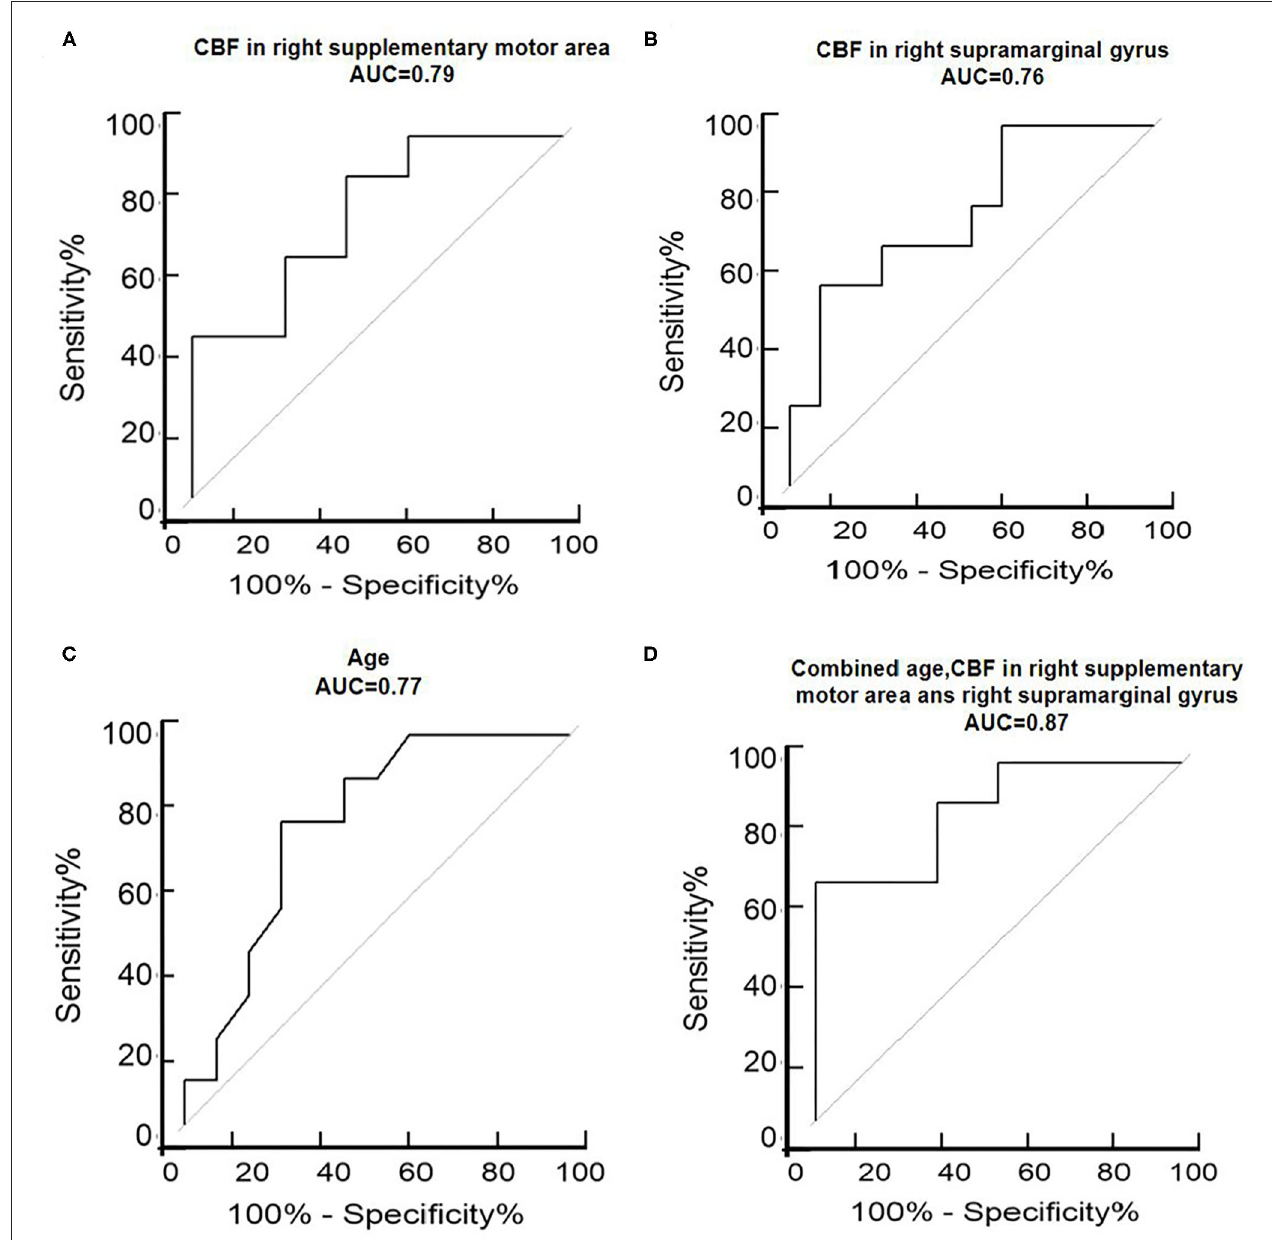
FIGURE 2 | ROC analysis of the right supplementary motor area (A) , right supramarginal gyrus (B) , age (C) , and combined age and CBF in the right supplementary motor area and right supramarginal gyrus (D) to assess the ability of regional CBFs to discriminate between AD depression and non-depression. ROC, receiver operating characteristic curve; AUC, area under the curve; L, left; R, right.